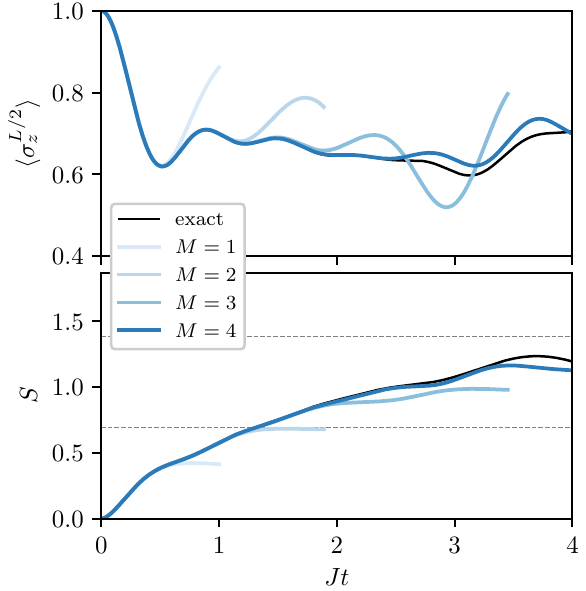
FIG. 4. Time evolution algorithm restricted to the quantum circuit ansatz for different orders M . We use g = 1.4 and h = 0.1, with N = 11 sites. In the top panel we show the magnetization on the central sites, and in the bottom panel we show the half-chain von Neumann entanglement entropy S . See Appendix C for more